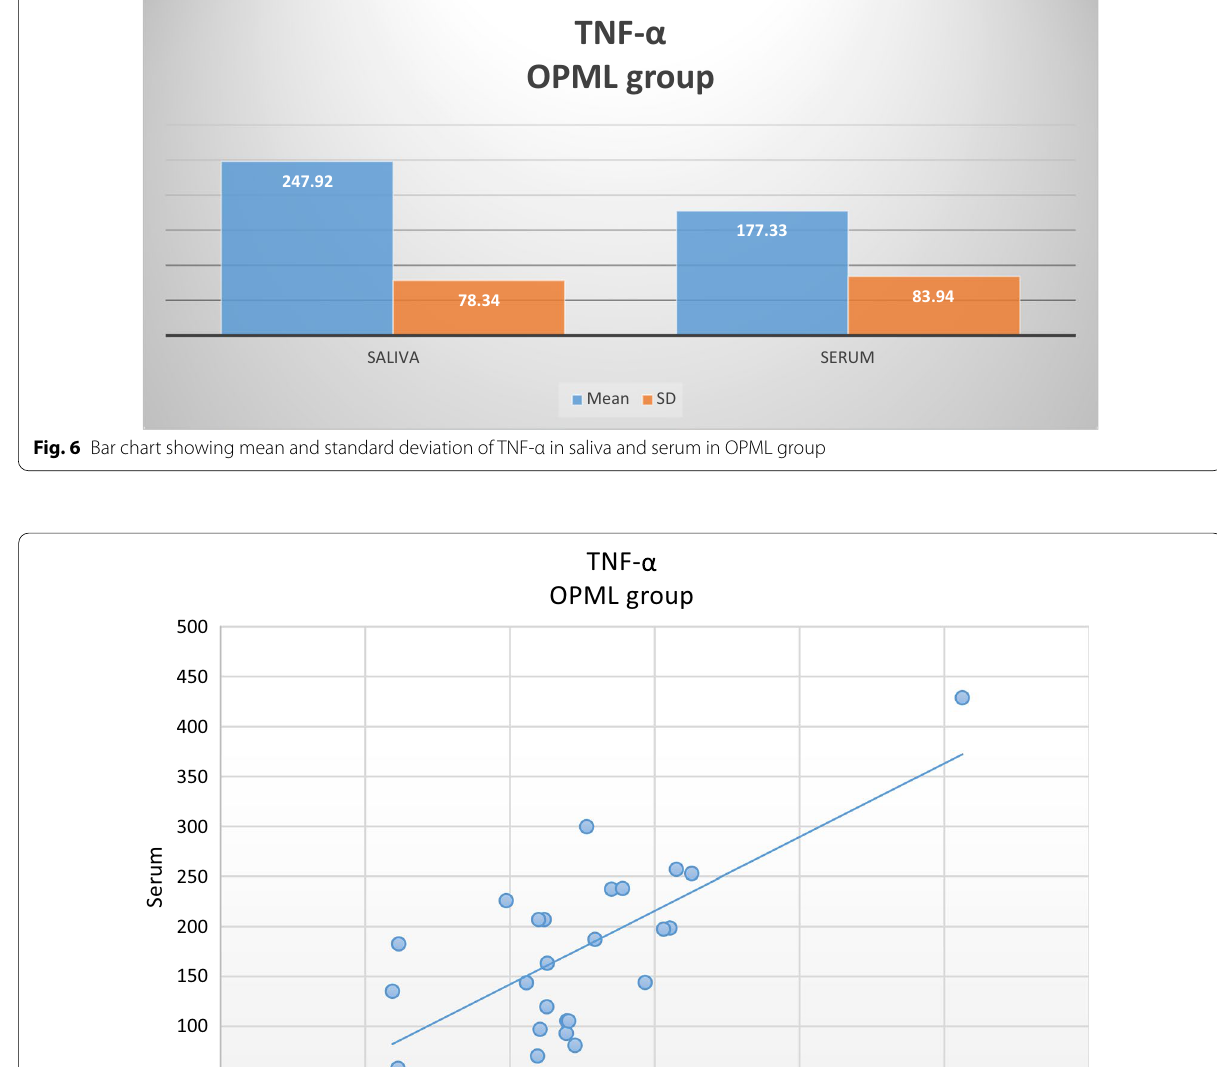
Comparison between both groups was performed by using independent t test, which revealed that the expres- sion of Ki-67 in OPML group was significantly higher than control group regarding both serum and saliva as P < 0.001, as presented in Table 6 and Fig. 15.